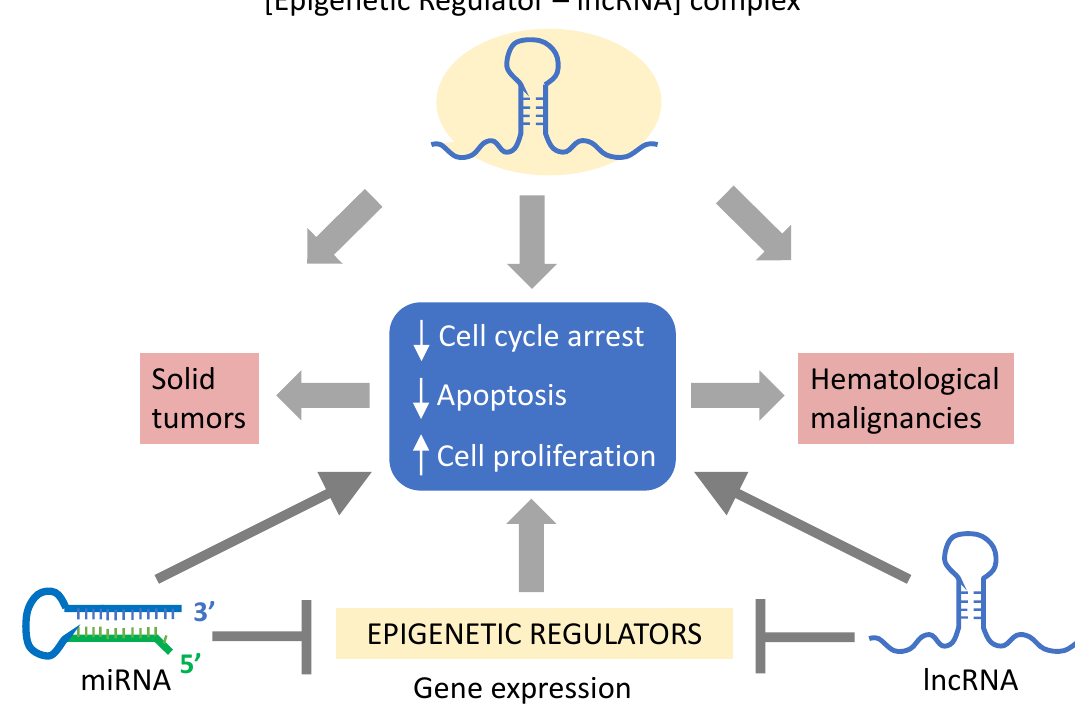
Figure 4. Environmental factors impact the link between the epigenome and ncRNAs. Environmental factors, including dietary changes and exposure to carcinogens, can a ff ect the expression of epigenetic regulatory complexes targeting the regulation of ncRNAs. Epigenetic modulation can either upregulate or downregulate the expression of ncRNAs, which, in turn, feed back onto the epigenetic landscape, promoting the gene expression profiles involved in